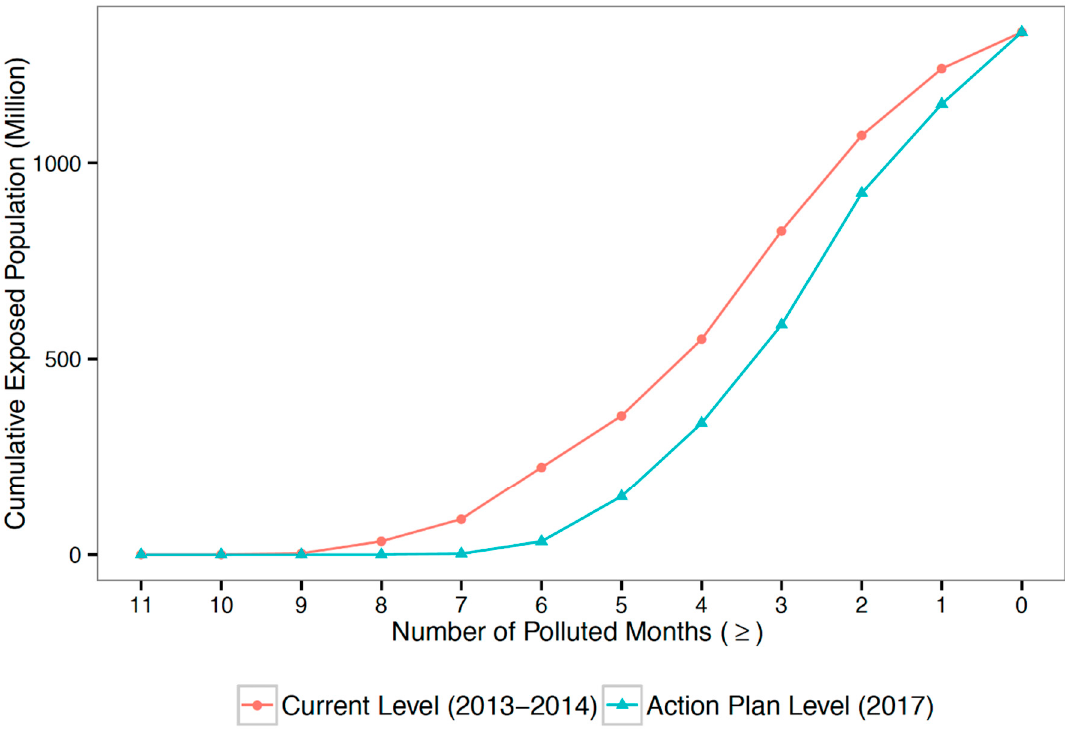
Figure 6. Simulation results for the effects of the Action Plan. Both curves use China’s daily PM 2.5 standard. The interpretation is the same as in Figure 2 .